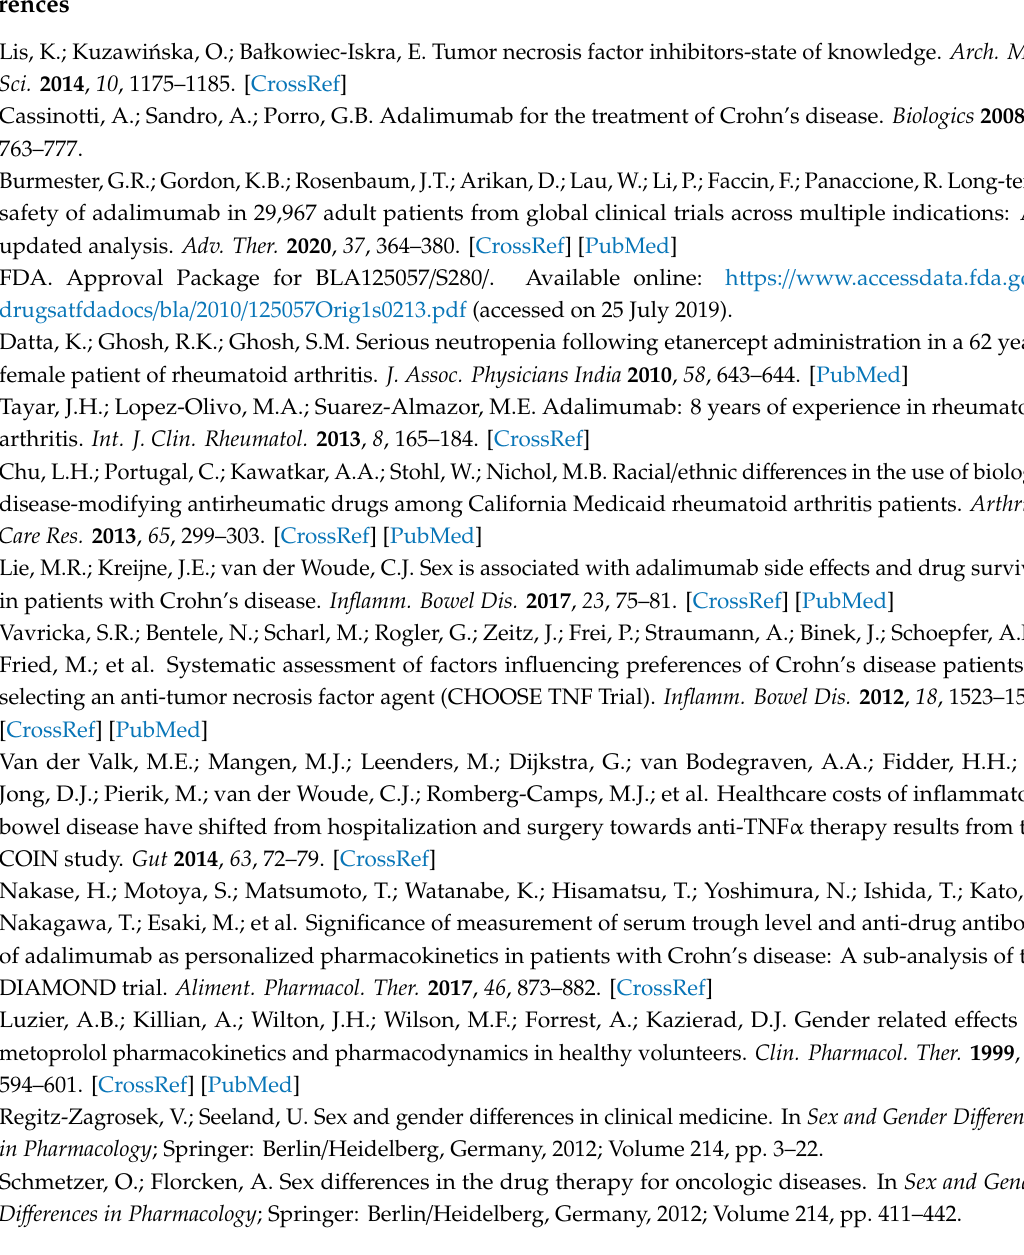
Table S1: Demographic characteristics of all patients administered adalimumab; Table S2: E ff ectiveness and ADR incidences in male or female patients sub-grouped by 50